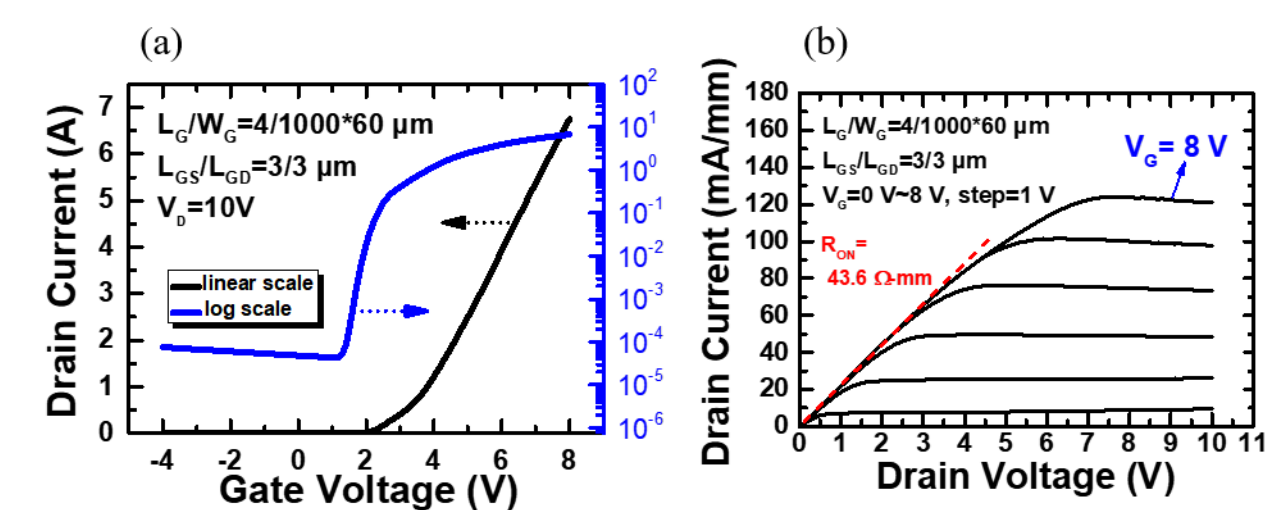
Figure 6. Device performance of the large-area p-GaN HEMT with total gate width 60 mm (1000 mm × 60 fingers). ( a ) Total drain current versus gate voltage at V DS = 10 V in linear and log scale. ( b ) Output performance at V DS = 0–10 V and V GS = 0–8 V.